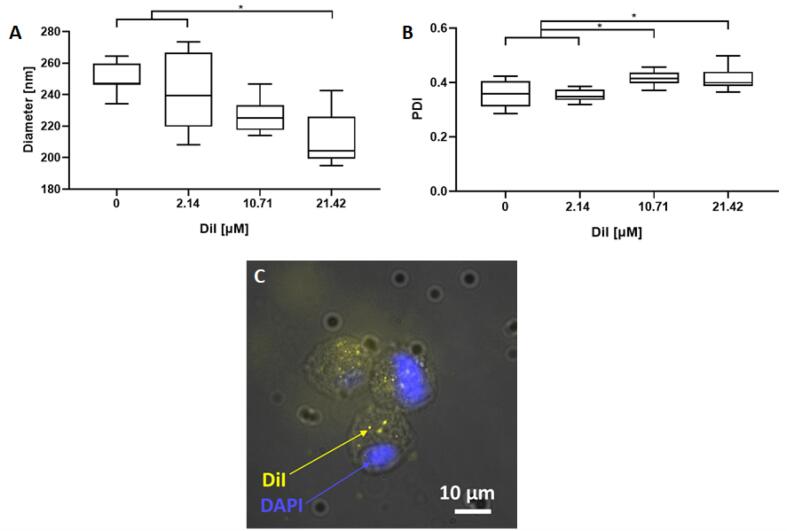
Effect of the quantity of DiI on ND size and size distribution. NDs were sonicated for a total active time of 60 s at 72 W, with a pulse of 7 s and 30% duty cycle. A) The boxplots show the diameter of NDs produced with different amounts of DiI. Increasing the quantity of DiI led to a small decrease in the size of NDs from 240.5 ± 23.7 to 211.8 ± 16.7 nm (*p < 0.05) B) Boxplots showing the polydispersity index (PDI) of NDs produced with different amounts of DiI. Three different samples were tested for each case (N = 3). C) The microscope image (40x oil immersion) shows three MG63 cells, where the blue circle is the cell nucleus stained with DAPI dye, while the yellow spots are NDs stained with DiI. (For interpretation of the references to colour in this figure legend, the reader is referred to the web version of this article.)